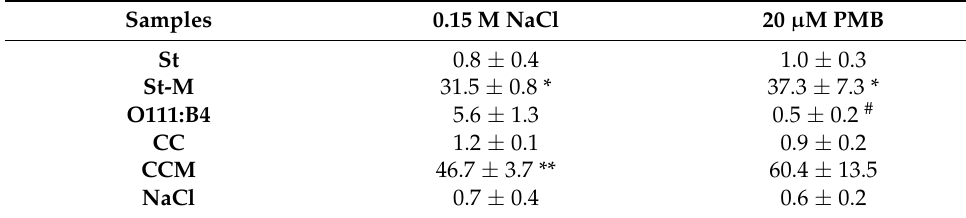
Figure 4. Typical details in light microscopy microphotographs of neutrophils incubated for 1 h with CC ( a – c ), CCM ( d – g ), and control with saline aliquot ( h , i ) (scale bars 10 µm). Black arrows indicate microparticles; white arrows indicate NET-like structures. Table 3. Amplitude of Luc-CL response (V) of neutrophils stimulated with suspension of St or St-M suspension and CC or CCM particles in the presence of 20 µ M polymyxin B sulfate (PMB) or without PMB (0.15 M NaCl was added). All measurements were performed in